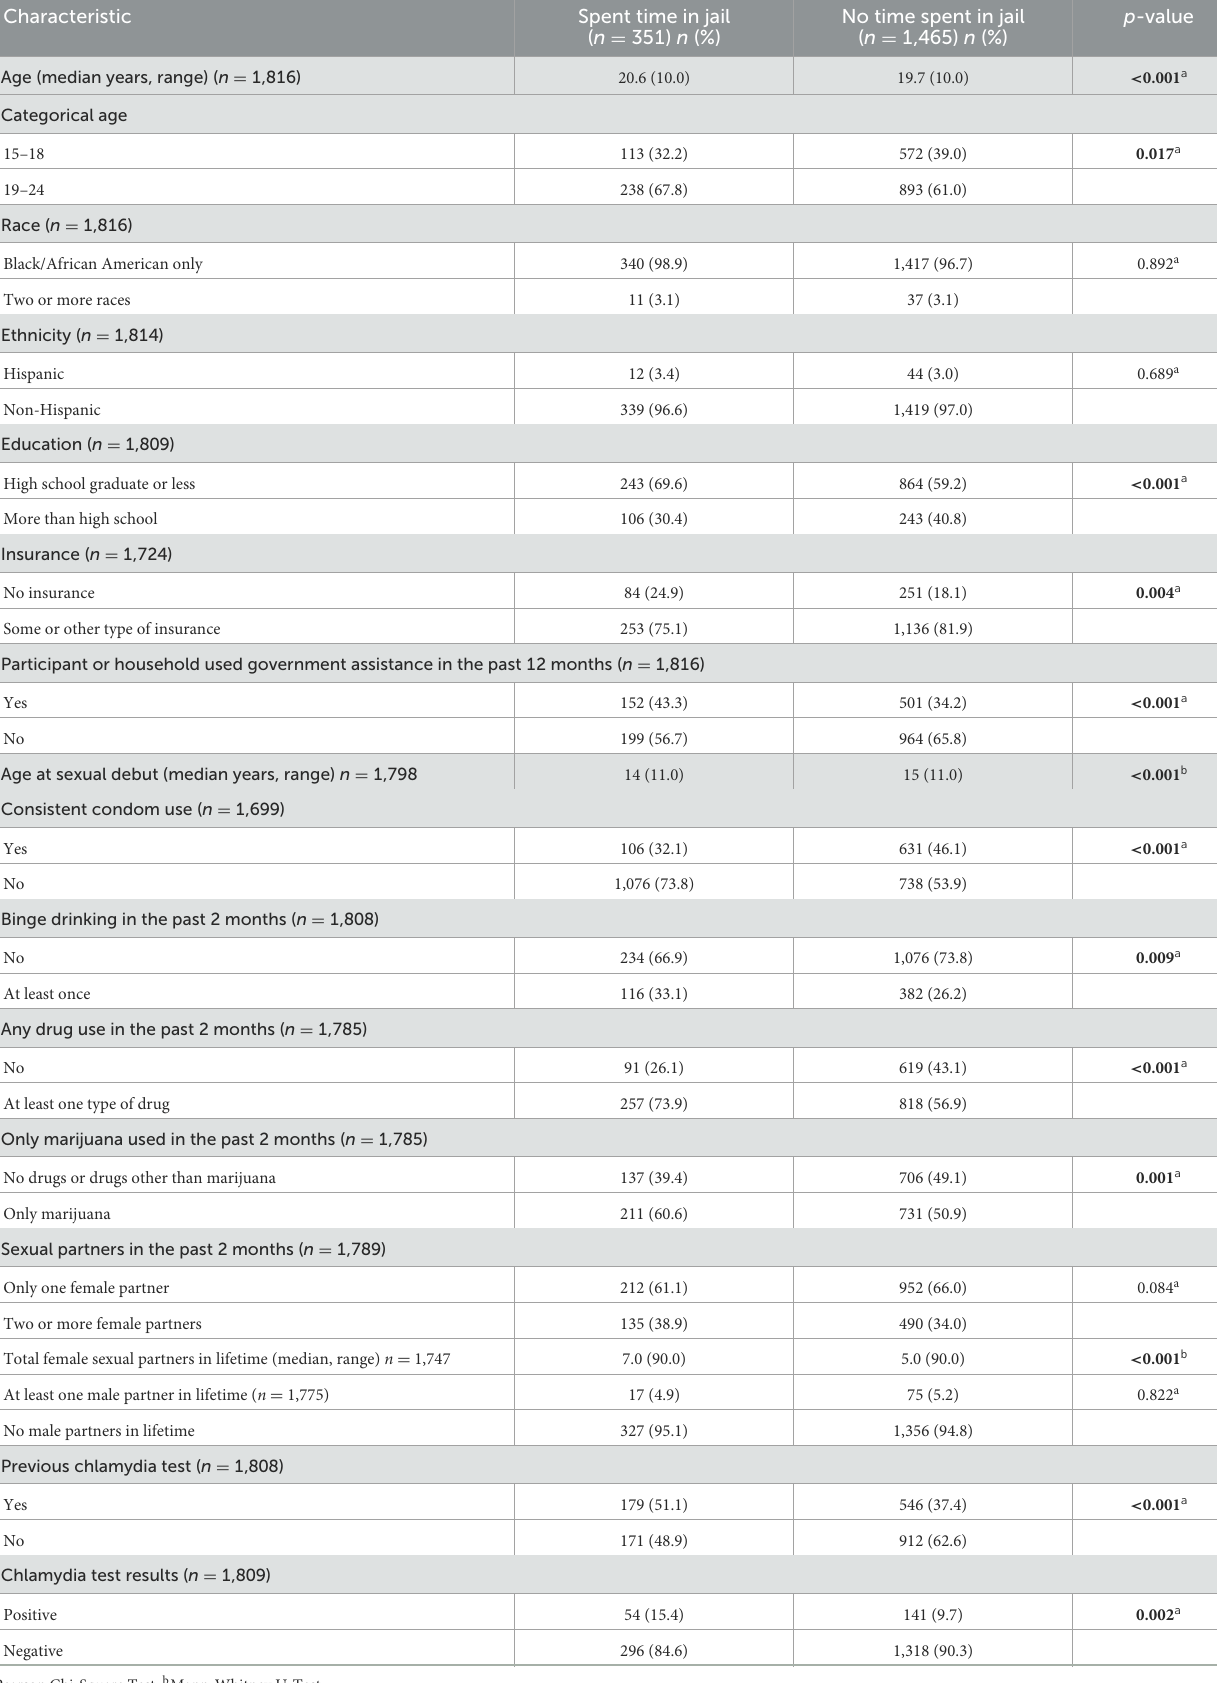
TABLE 2 Characteristics by participants’ incarceration history ( n = 1,816).